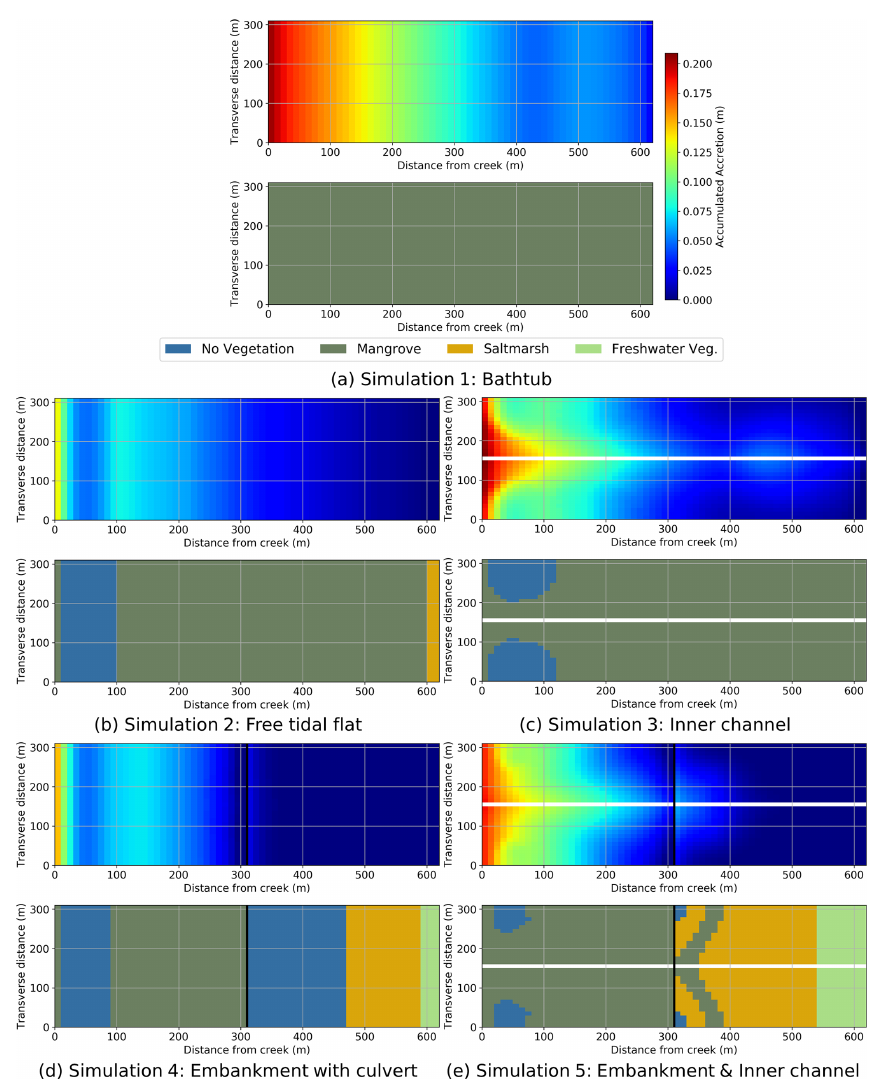
Figure 2. Accumulated accretion (top) and vegetation maps (bottom) in 2050 for low sediment input corresponding to (a) Simulation 1, (b) Simulation 2, (c) Simulation 3, (d) Simulation 4, and (e) Simulation